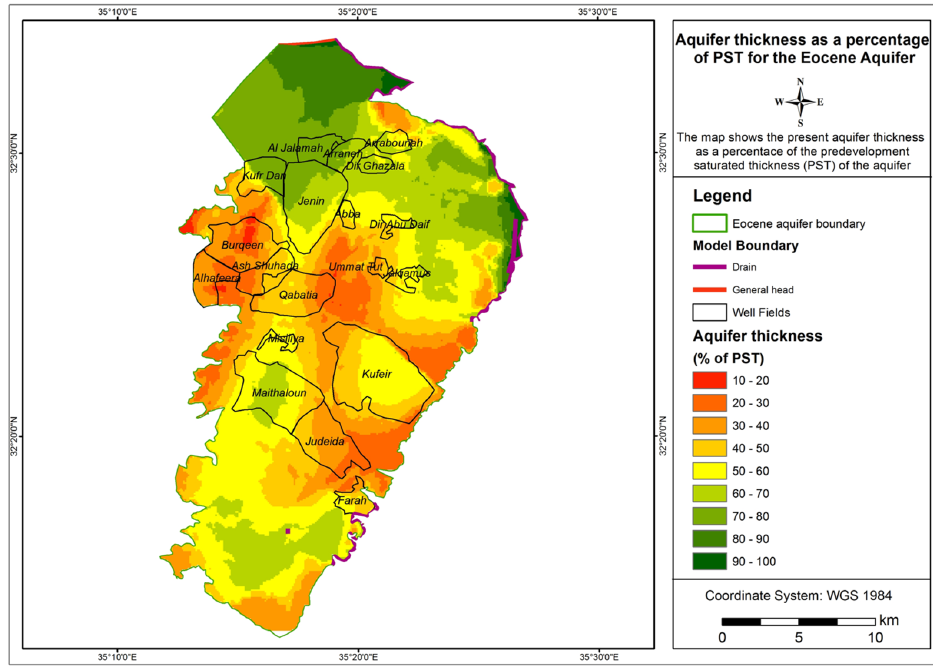
Figure 15. Simulated saturated thickness as percentage of PST for the Eocene aquifer.